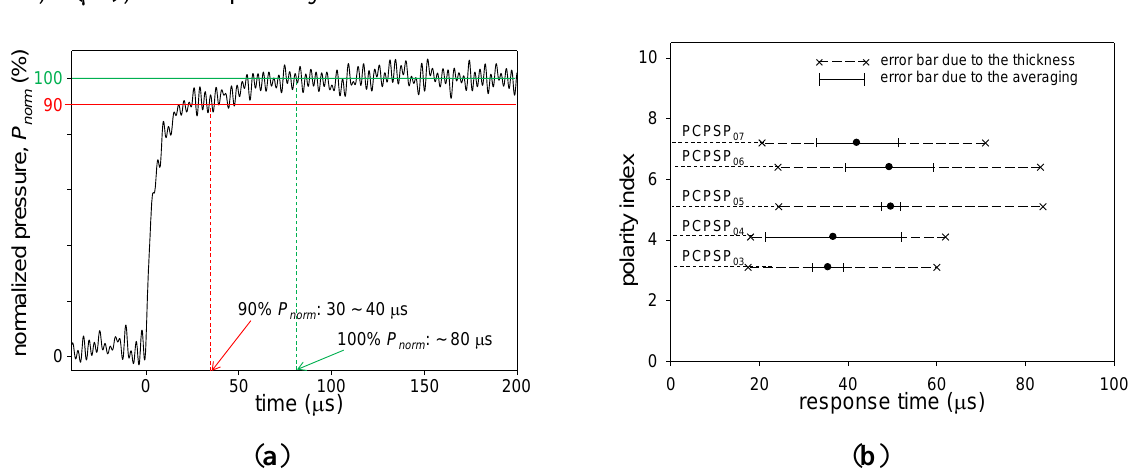
. ( b ) Relationship between the response 03